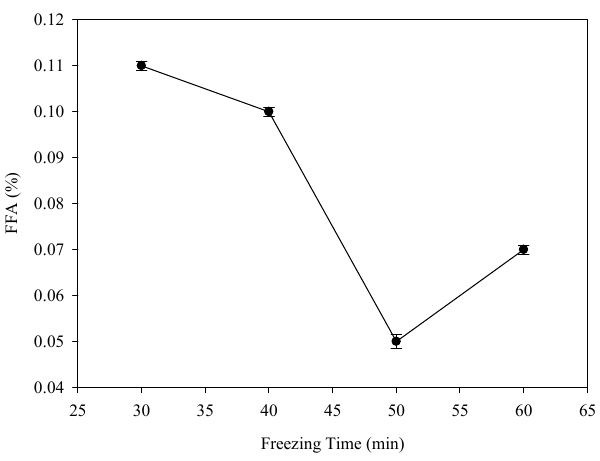
Figure 5. Changes of FFA (%) content in the separated oil from the kitchen wastewater at different freezing time (min). freezing time